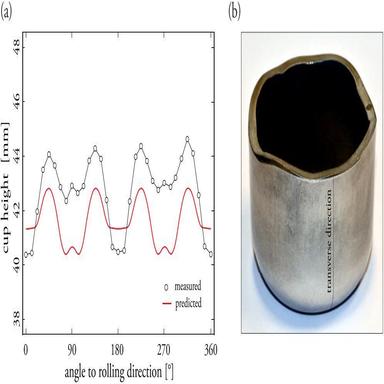
Deep drawing of the cylindrical cup: (a) The cup height with respect to the angle θ. (b) The height profile of the drawn cup results in six ears, which has been confirmed also by the simulation.